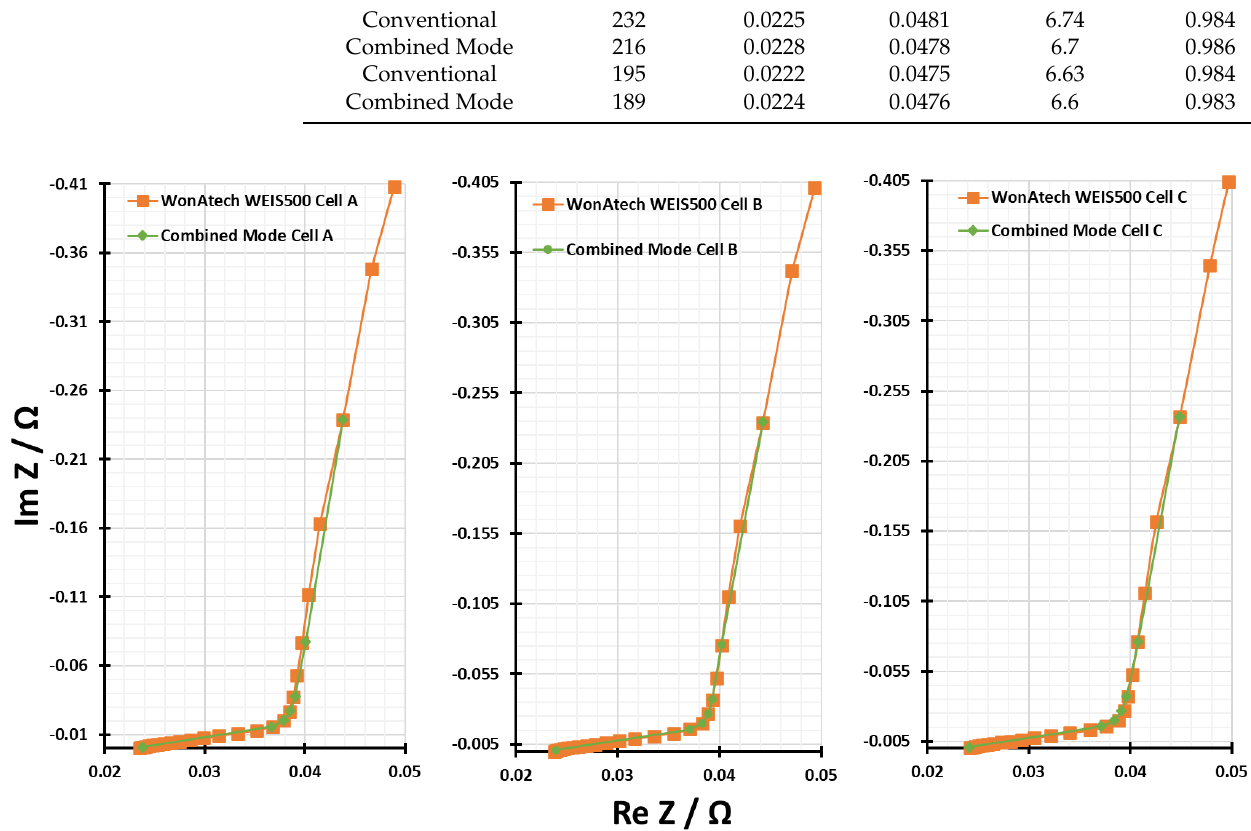
Figure 15. Comparison of EIS results by WEIS500 and the developed instrument for three supercapacitors A, B, C (C = 10 F, Vrated = 2.7 V). Table 1. Comparisons of the parameters of samples A, B and C obtained by the proposed method and WEIS500 workstation.